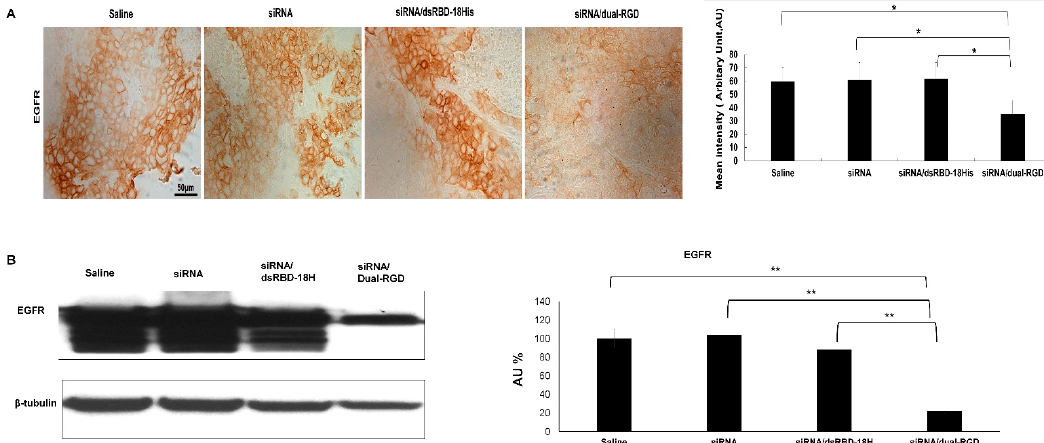
Figure 7. Evaluation of target gene knockdown in vivo. MDA-MB-231 cell xenografts were treated with EGFR siRNA/dual- RGD or controls twice a week for four weeks. ( A ) EGFR expression was detected by IHC. Formalin-fixed, paraffin-embedded sections of xenograft tumors were stained with anti-EGFR antibodies compared with controls of saline, siRNA, and siRNA/dsRBD-18His. IHC measurement was performed with ImageJ plugin IHC profiler. Scale bar, 50 µm. * p < 0.05 ( B ) Tumor EGFR protein expression was measured by Western blot. Quantification of protein levels normalized by GAPDH using ImageJ. The results are the pool of three mice per group. ** p < 0.01.